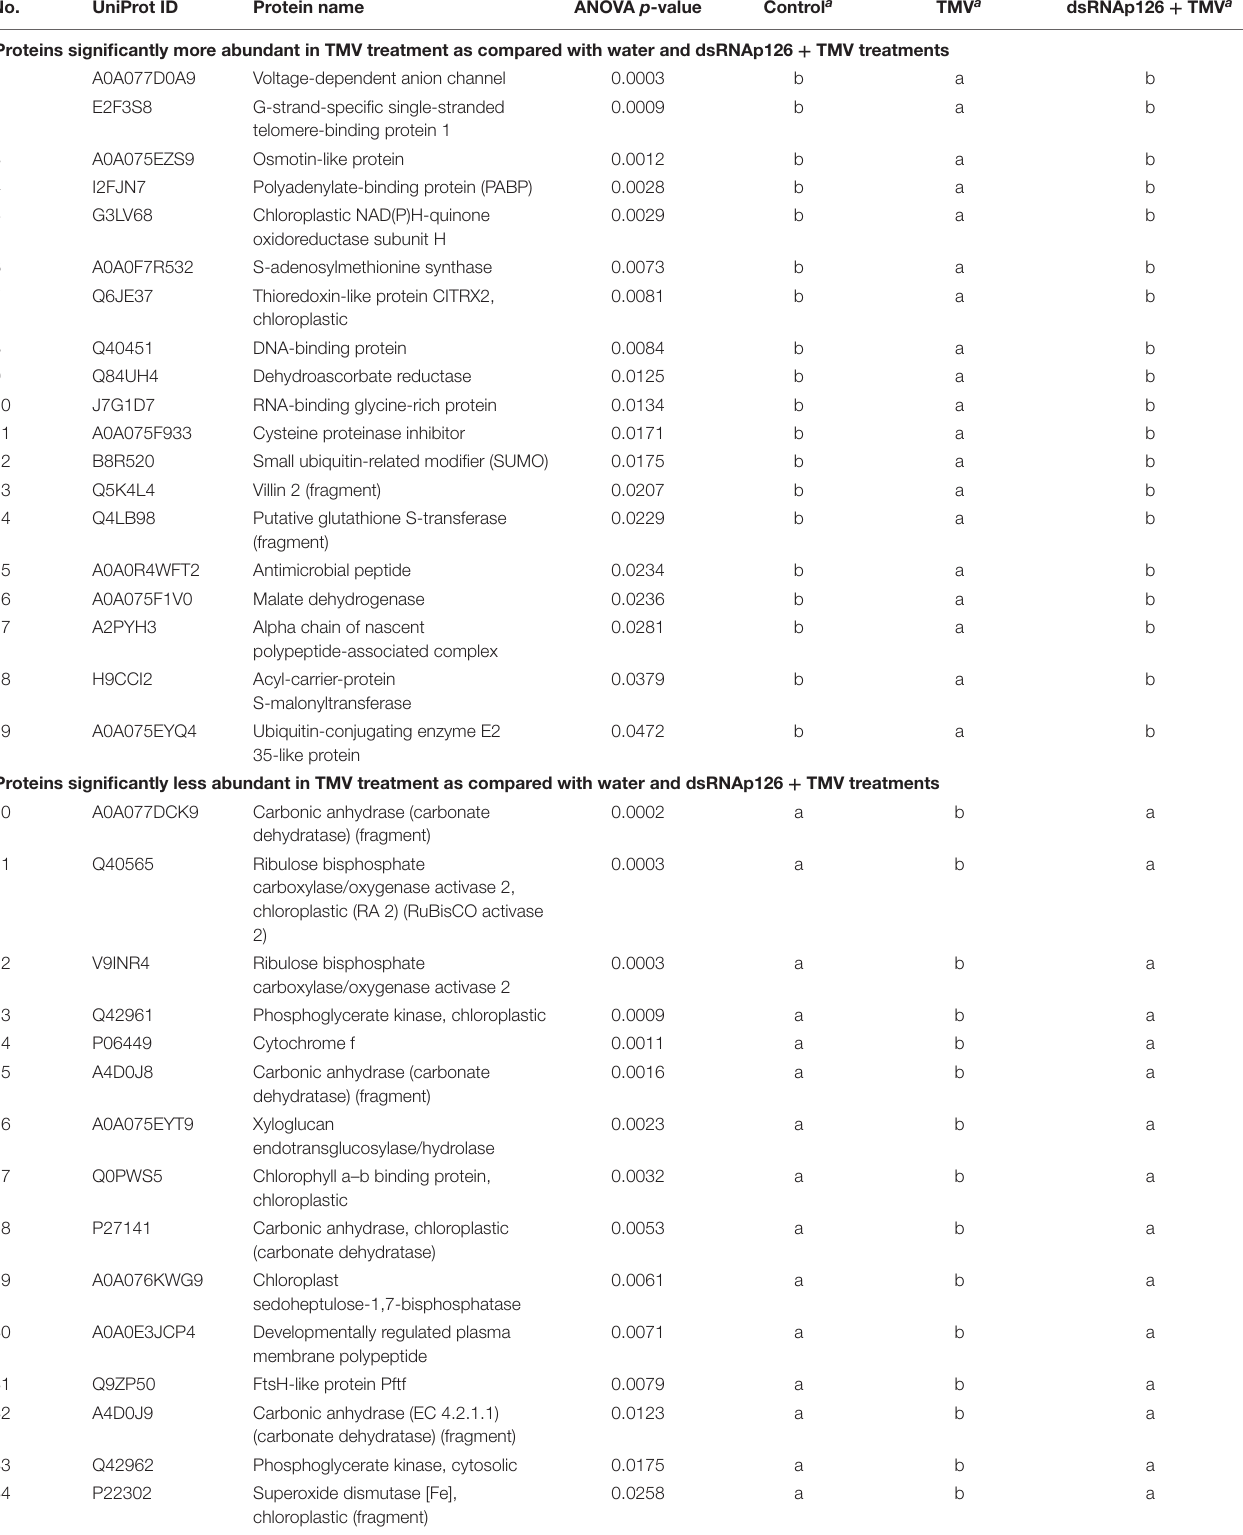
TABLE 1 | List of differentially accumulated proteins (DAPs). No. UniProt ID Protein